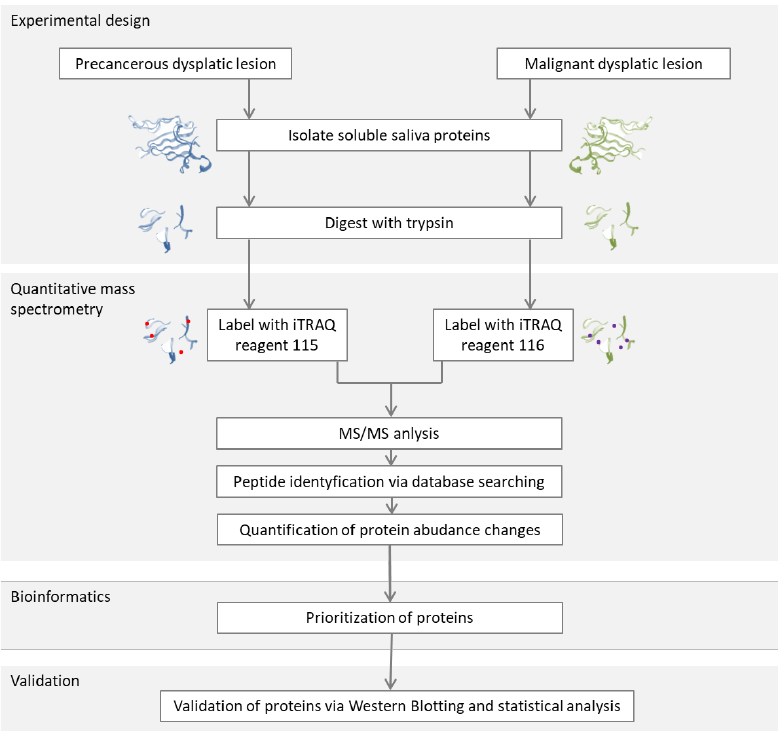
Figure 7. Schematic representation of the strategy of salivary proteome analysis from people with precancerous dysplastic lesion and malignant dysplastic lesions